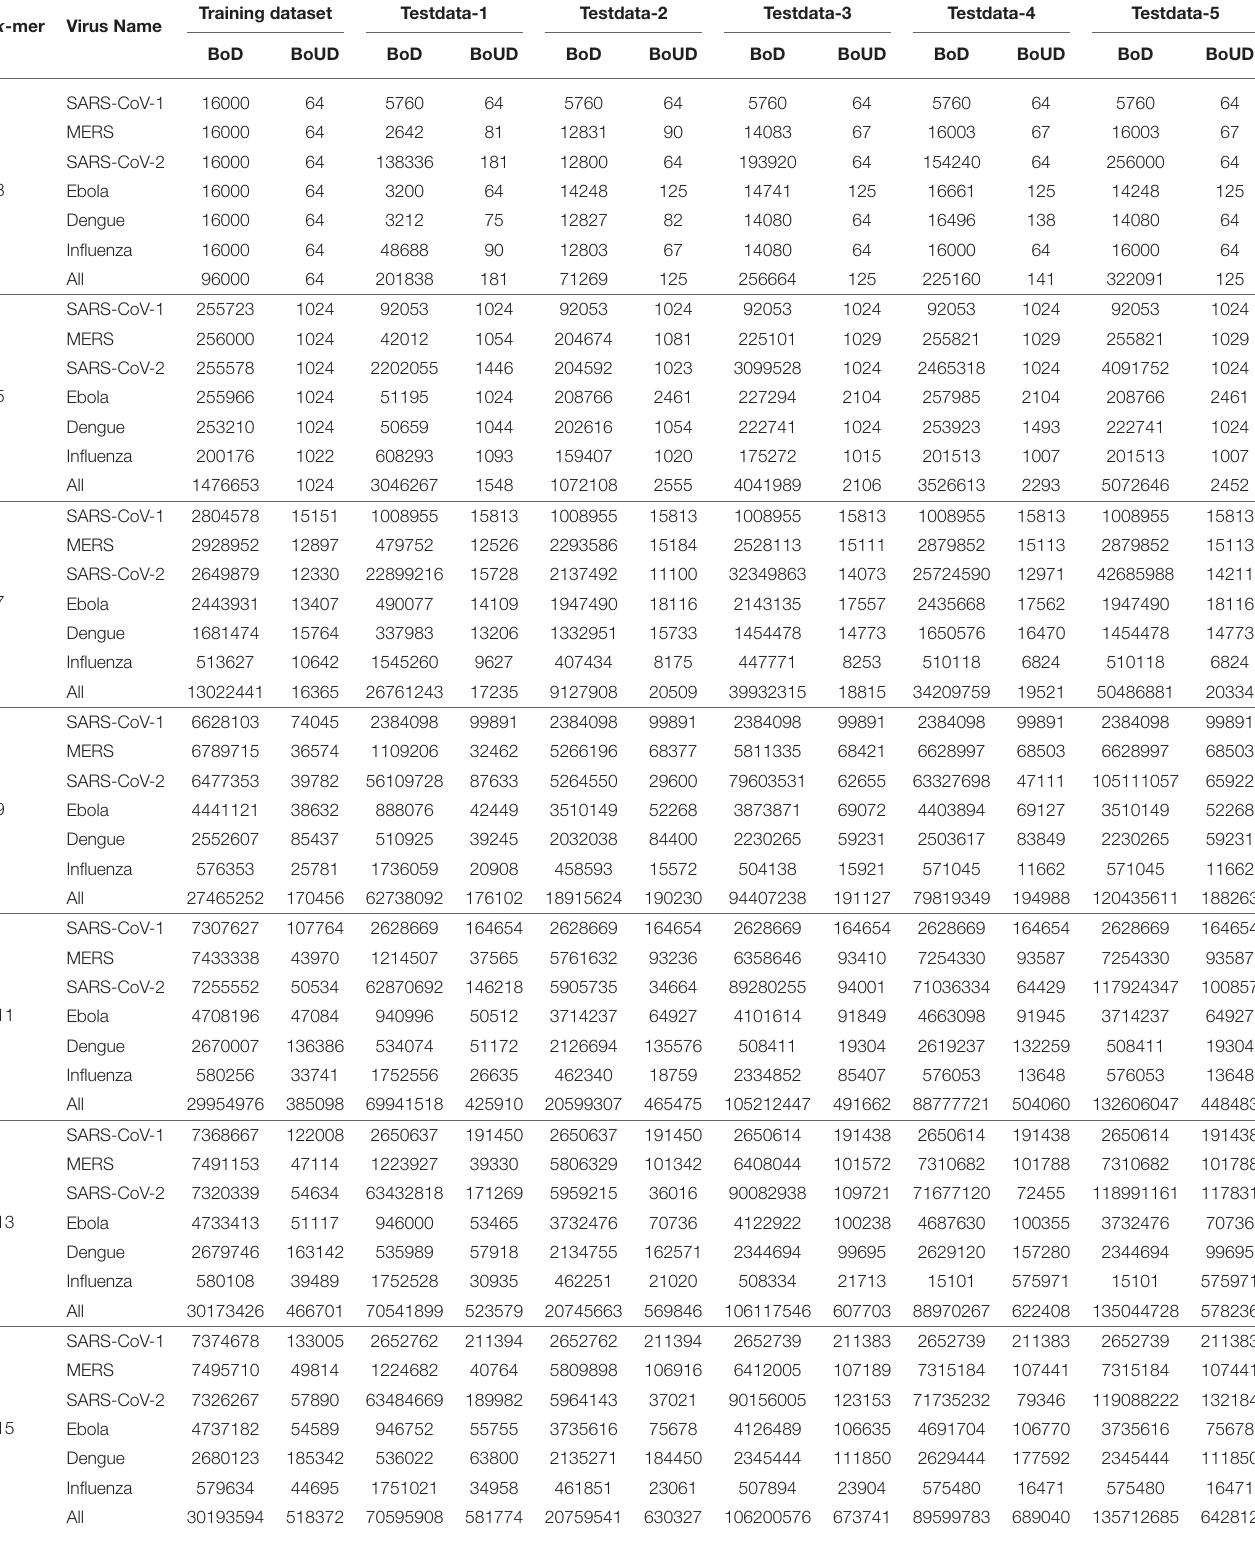
TABLE 3 | Bag-of-Descriptors and Bag-of-Unique-Descriptors for each virus